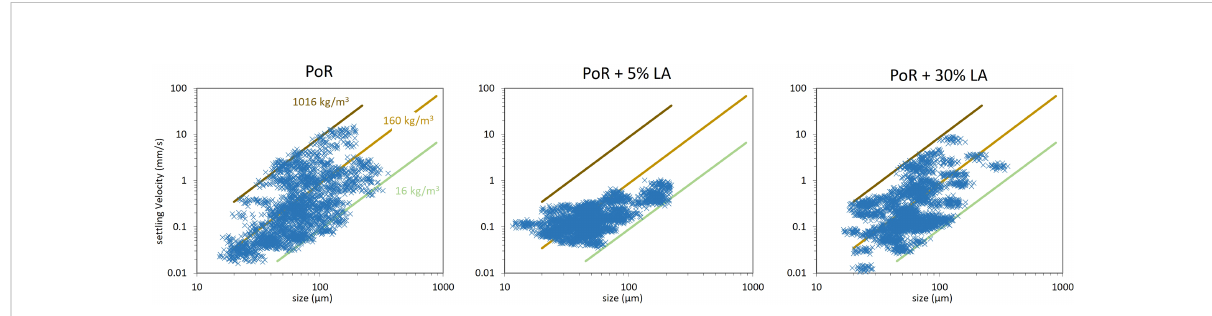
FIGURE 8 Settling velocity as function of mean size (equivalent diameter) determined by LabSFLOC2 experiments.